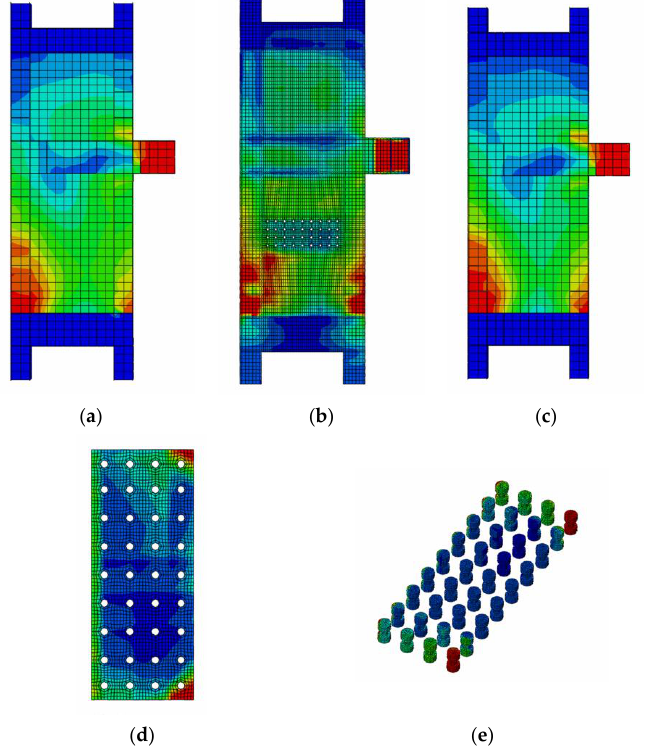
Figure 31. Failure patterns of steel members of three numerical models. ( a )Embedded SPSW of CS-1; ( b ) Embedded SPSW of CS-2; ( c ) Embedded SPSW of CS-3; ( d ) Faceplate of CS-2; ( e ) Bolts of CS-2.